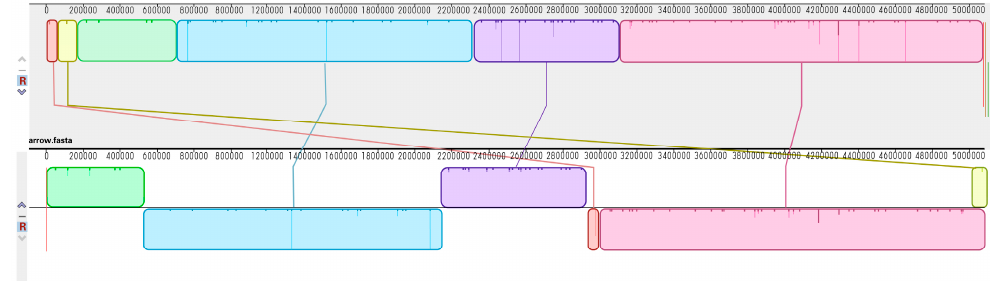
Figure 4. Genome comparisons of the selective E. coli genome. The alignment between OLA-treated E. coli ATCC25922 genome (above) and reference E. coli ATCC25922 (NCBI accession No. GCF_000743255.1) (below) is displayed as one horizontal panel per input genome sequence. Colored blocks in the first genome are connected by lines to similarly colored blocks in the second genomes. These lines indicate which regions in each genome are homologous. When a block lies above the center line the aligned region is in the forward orientation relative to the first genome sequence. Blocks below the center line indicate regions that align in the reverse complement orientation. Inside each block Mauve draws a similarity profile of the genome sequence. The height of the similarity profile corresponds to the average level of conservation in that region of the genome sequence. Using MUMmer(v3.23), the genome of the OLA-resistant bacteria was compared with the reference genome (NCBI accession No. GCF_000743255.1), and 715 SNP sites were obtained, among which 270 SNP sites involving 41 genes existed in the exon region, causing non-synonymous mutations or codon termination. In the meantime, 82 indel sites were obtained, among which 27 indel sites existed in the exon region (Table 3). There were 113 SNP sites and 19 indel sites associated with the DNA replication fork binding protein CrfC, which plays important functions such as cell replication, recombination, and repair. Only three SNP sites and one indel locus were involved in DNA binding, transcriptional regulation, and recombination genes. There was an SNP site observed in drug/metabolite transporter gene yddG and a SNP site efflux gene acrB . There were four SNP sites and one non-frameshift deletion found in NAD + oxidoreductase gene. These results indicated that the bacterial resistance to QdNO drugs could be related to NAD + redox and efflux pump. (Table 3), six identical SNP sites, degQ , ks71A , vgrG , bigA , cusA , and DR76 - 4702 , were found. vgrG and bigA have different mutation sites, and the other 4 genes have only one mutation site in both of the sequencing profiles. Other SNPs included amino acid metabolism, integral component of membrane, ion transport, and nucleic acid metabolism. Table 3. Non-synonymous mutations in resistant E. coli ATCC25922 induced by sub-MIC of OLA.